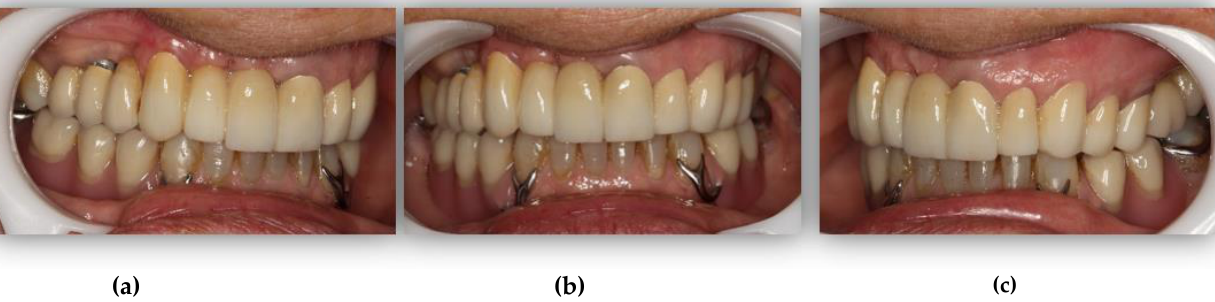
Figure 2. Intra-oral photographs of the patient depicted in Figure 1, after oral rehabilitation (TGA): ( a ) right view; ( b ) frontal view; ( c ) left view.